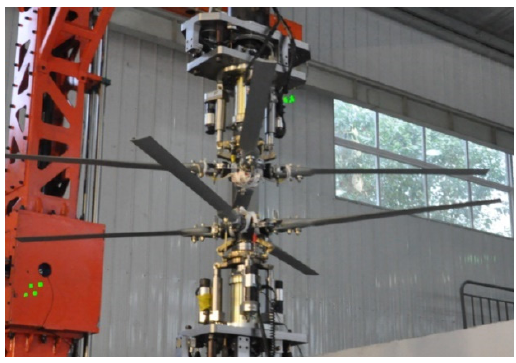
Figure 2. Installation of the upper and lower rotors in the test rig. Table 1. Balance capacity and calibration accuracy.